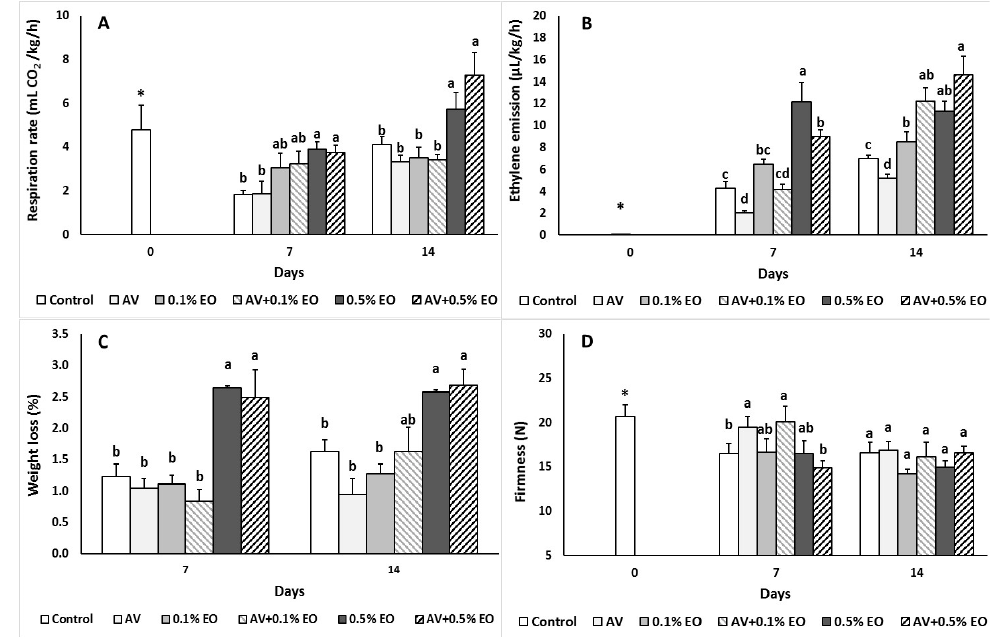
Figure 1. Impacts Aloe vera (AV at 10%) coating and/or sage essential oil (EO at 0.1% and 0.5%) on ( A ) respiration rate (mL CO 2 /kg/h), ( B ) ethylene emission ( μ L/kg/h), ( C ) weight loss (%) and ( D ) firmness (expressed in Newton) in tomato fruit following storage for 7 and 14 days. Fruit were maintained throughout at 11 ◦ C and 90% RH. Values represent mean ( ± SE) of measurements made on eight independent fruit per treatment and storage period. On the columns, significant di ff erences ( p < 0.05) among treatments are indicated by di ff erent Latin letters for di ff erent days. Symbols of * or ns indicating significance or not, respectively, among controls through storage